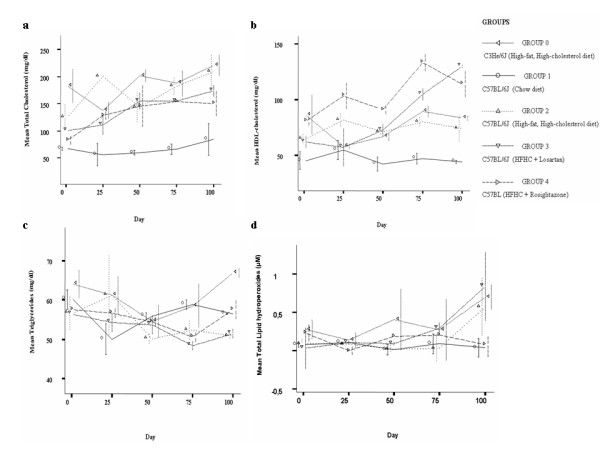
Mean total cholesterol (a), HDL-cholesterol (b), triglycerides (c) and lipid hydroperoxides (d) content in plasma of study groups. Triplicate measurements were taken in three animals per group before the onset of the study period (day 0), at day 1 and each 25 days elapsed after completing 100 days. Inter-group comparisons were made at day 1 and at day 100 and intra-group between days 1 and 100. Data are expressed as mean ± SD.